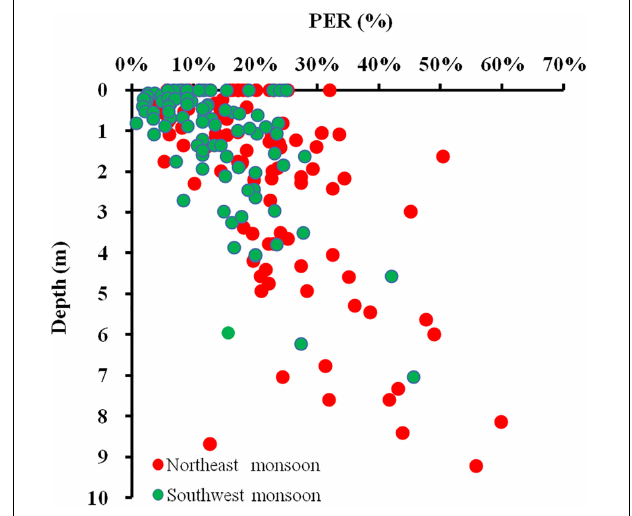
FIGURE 11 | Relationship between in-depth and volumetric PER for all DOC production experiments conducted in the Qinzhou